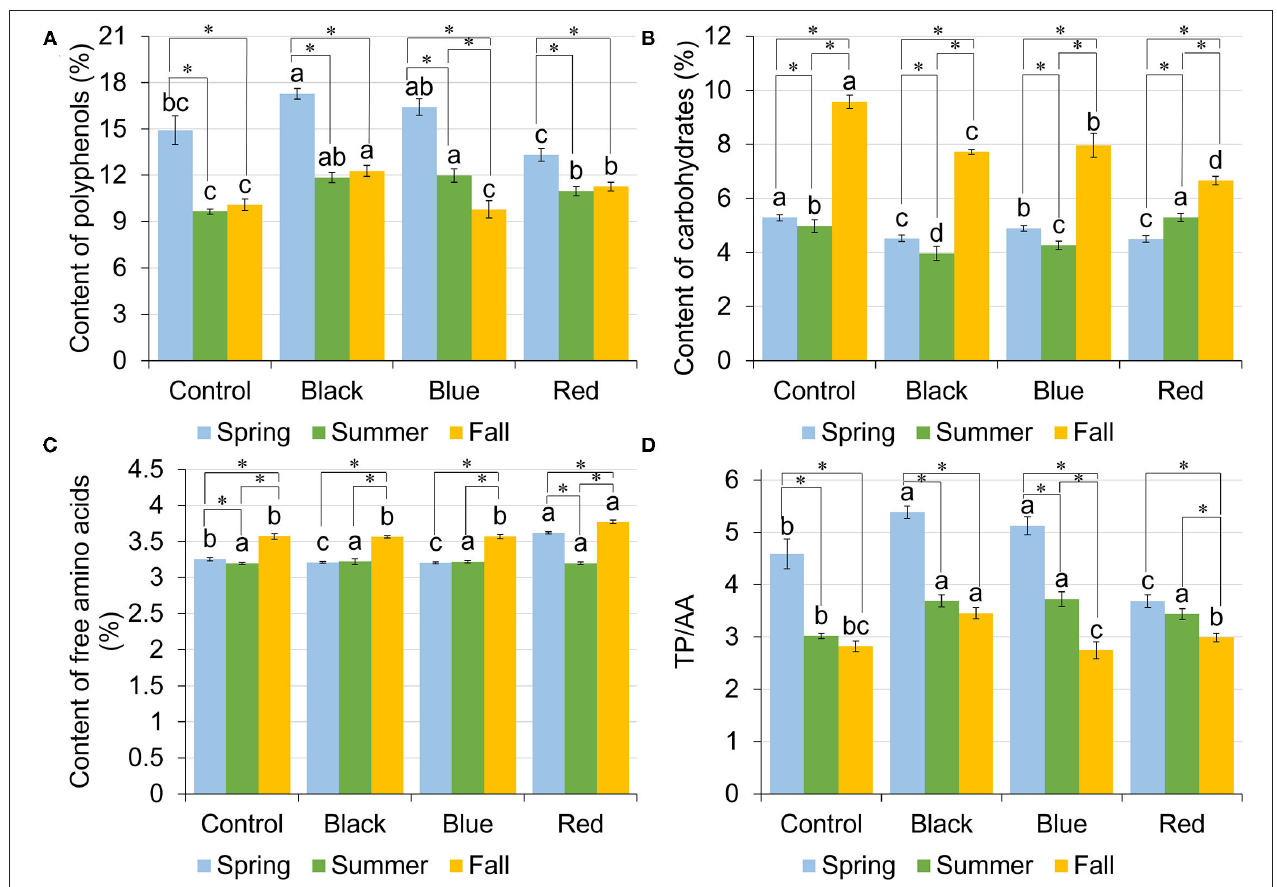
FIGURE 3 | Content of total polyphenols (TPs) [gallic acid equivalents (GAE) % dry matter] (A) , carbohydrates (dextrose equivalents % dry matter) (B) , free amino acids (AAs) (L-theanine equivalents % dry matter) (C) , and the ratio between TPs and free AAs (D) in tea leaves collected from plants under different shade treatments in spring, summer, and fall. Different letters on top of the same-colored columns represent significant difference between the shade treatments within one season; *connected different columns represent significant difference within one shade treatment between seasons. All the significant differences were indicated by Tukey’s HSD test at p ≤ 0.05.